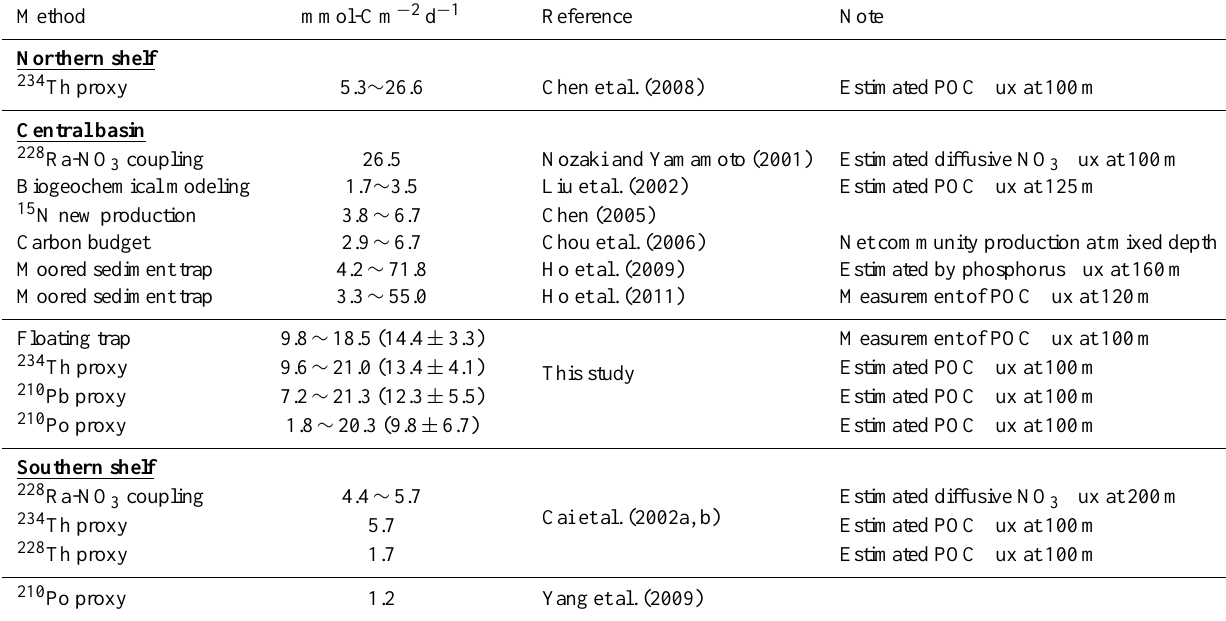
Table 4. Export production estimated by various methods in the South China Sea. Average and standard deviation of various fluxes from this study are shown in